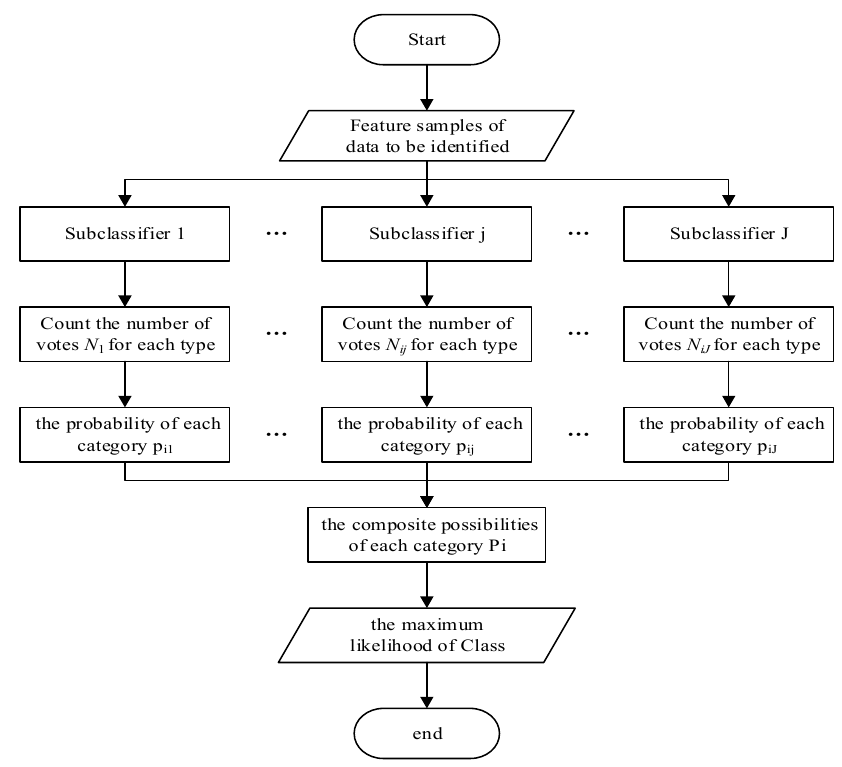
Figure 2. Random forest structure.